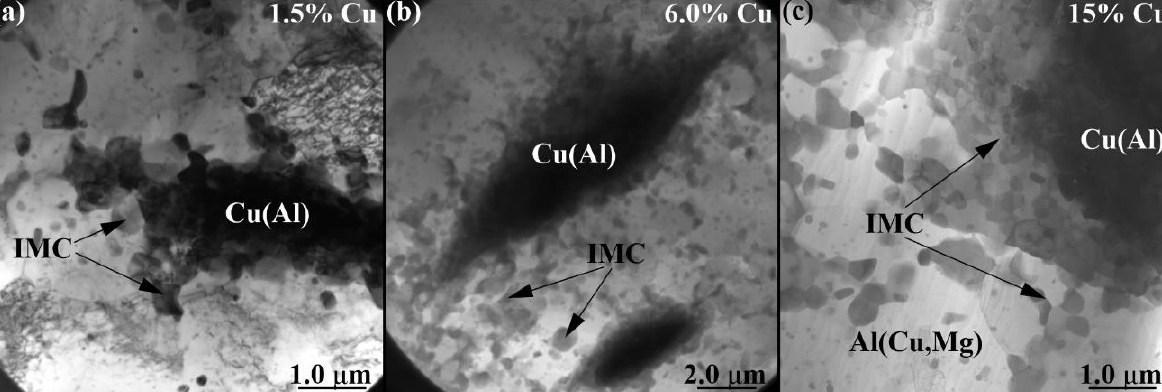
Figure 14. The bright-field TEM images of IMC agglomerate particles in the 4-pass samples after FSP with 1.5 vol.% ( a ), 6.0 vol.% ( b ) and 15 vol.% Cu ( c ).